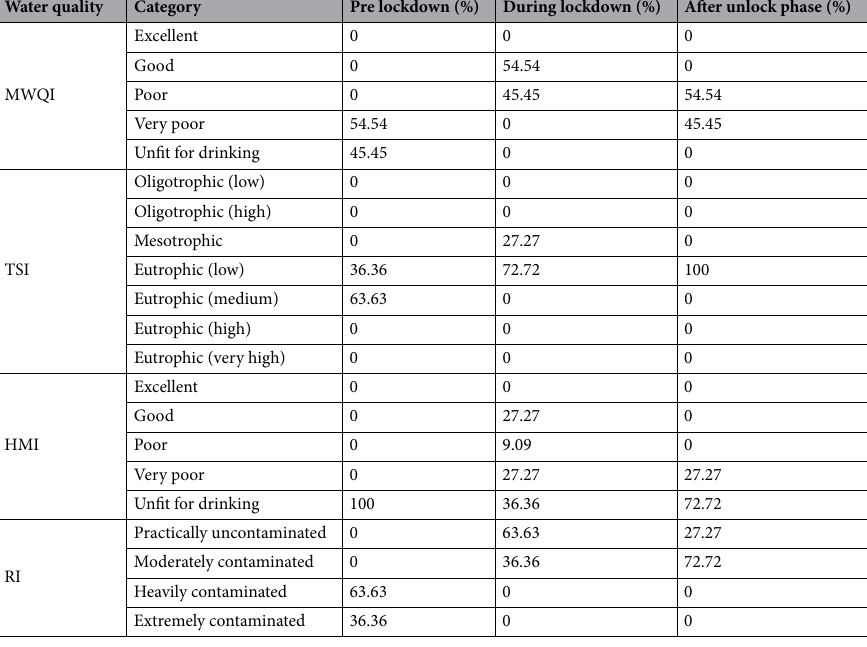
Table 4. Water samples under each category of MWQI, HMI, RI and TSI in three